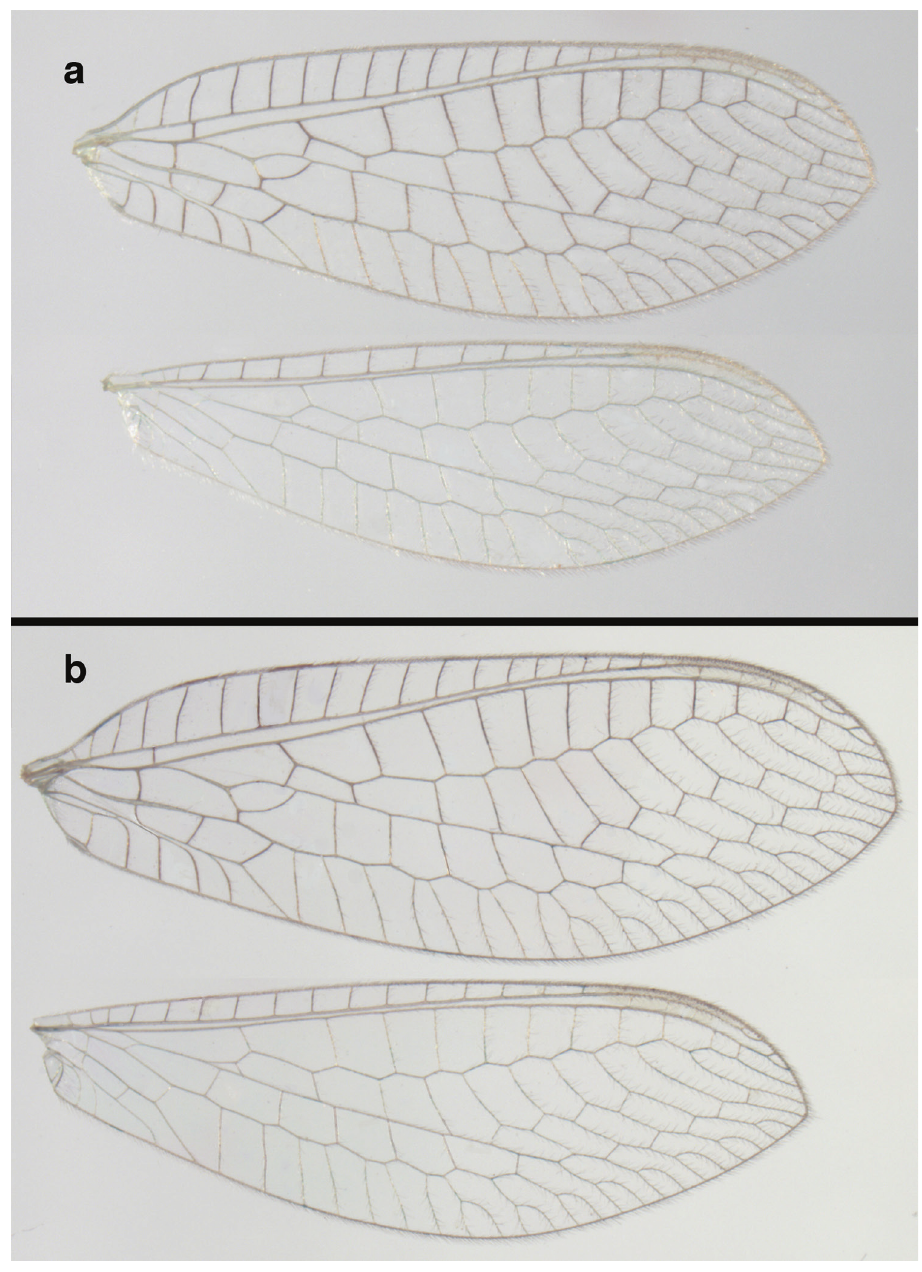
Figure 45. Ungla grandispiracula Tauber, sp. n. Wings, ( a ) male, holotype ( b ) female, paratype (all: Colombia, Antioquia,